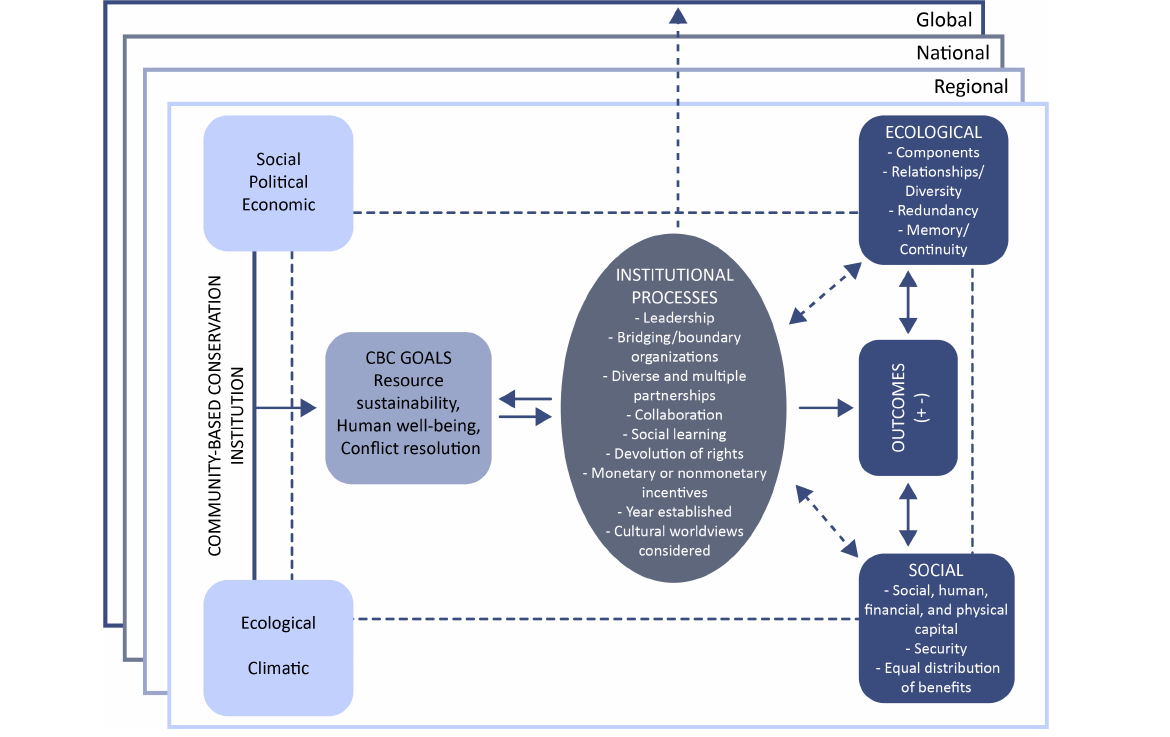
Fig. 1 . Community-based conservation (CBC) conceptual model adapted from Berkes (2004, 2007), Plummer and Armitage (2007), Seixas and Davy (2008), and Seixas and Berkes (2010), among others. An array of components existing within and beyond CBC institutions interact to influence the sustainable and unsustainable social and ecological outcomes of their actions. This includes exogenous drivers of CBC formation such as ecology, climate, social, political, and economic factors, which occur across scales (local to global), as well as the processes that shape and are shaped by CBC institution goals. We focus our review on the types of outcomes reported and the institutional processes, or conditions, thought to lead to successful